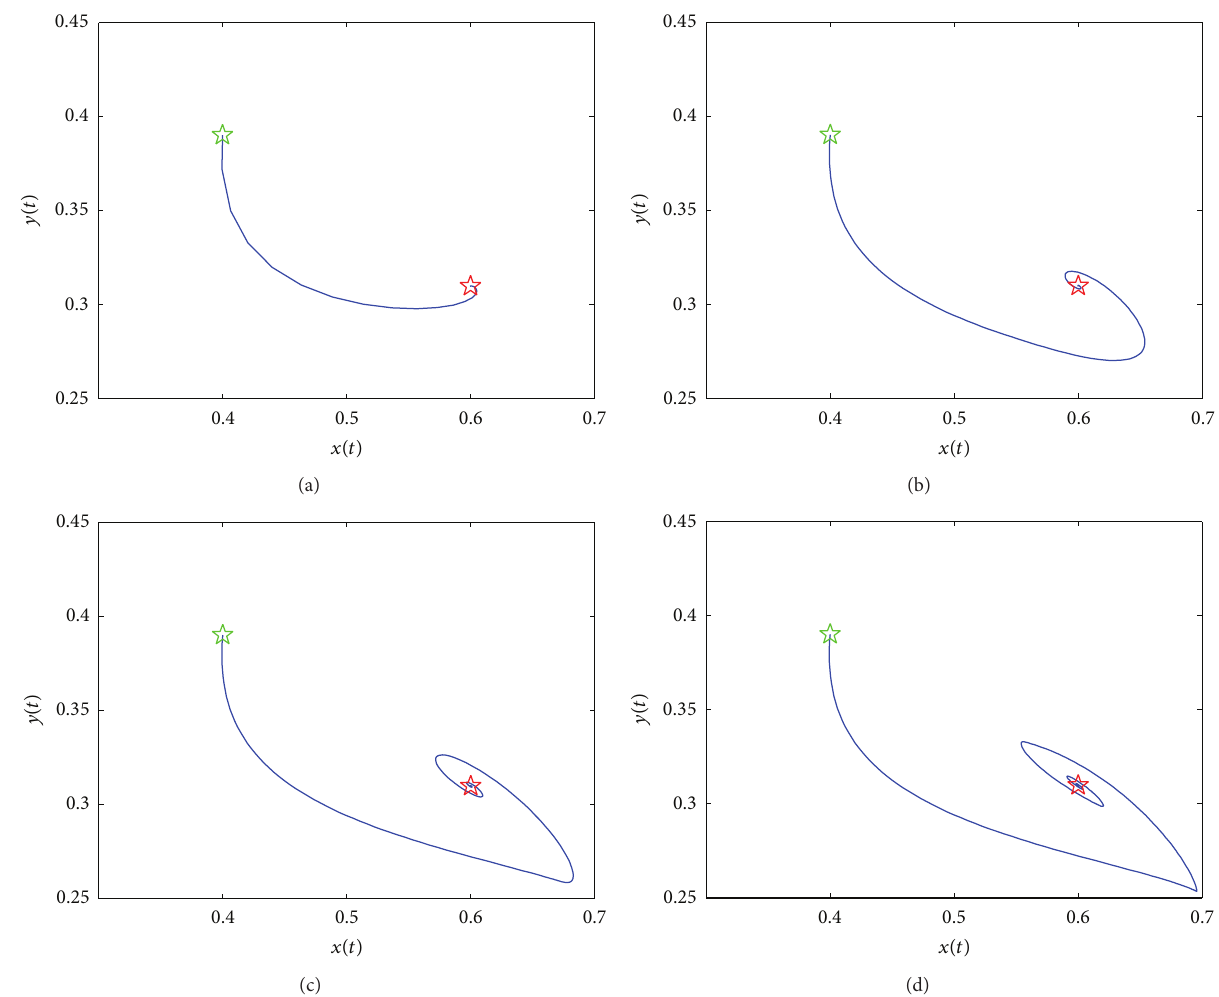
Figure 1: The phase portraits of system (5). Initial values 𝑥 0 = 0.4 , 𝑦 0 = 0.39 . Parameters 𝑠 = 1 , 𝑐 = 0.4 . Delay values (a) 𝜏 = 0 , (b) 𝜏 = 5 , (c) 𝜏 = 10 , and (d) 𝜏 = 15